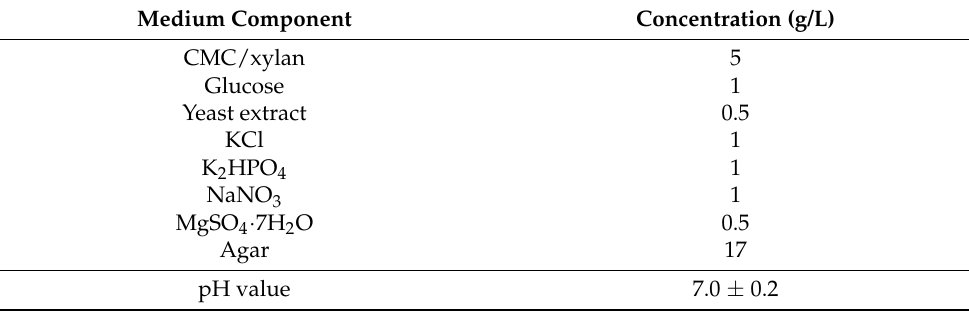
Table 2. Medium composition for the cellulase and xylanase activity screening.